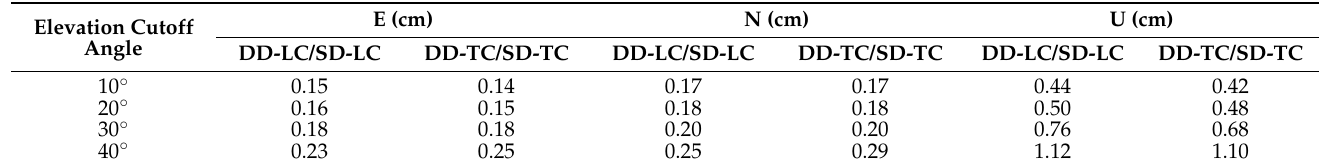
Table 5. The positioning RMS errors of the DD-LC, DD-TC, SD-LC, and SD-TC models under different elevation cutoff angles in the single-epoch